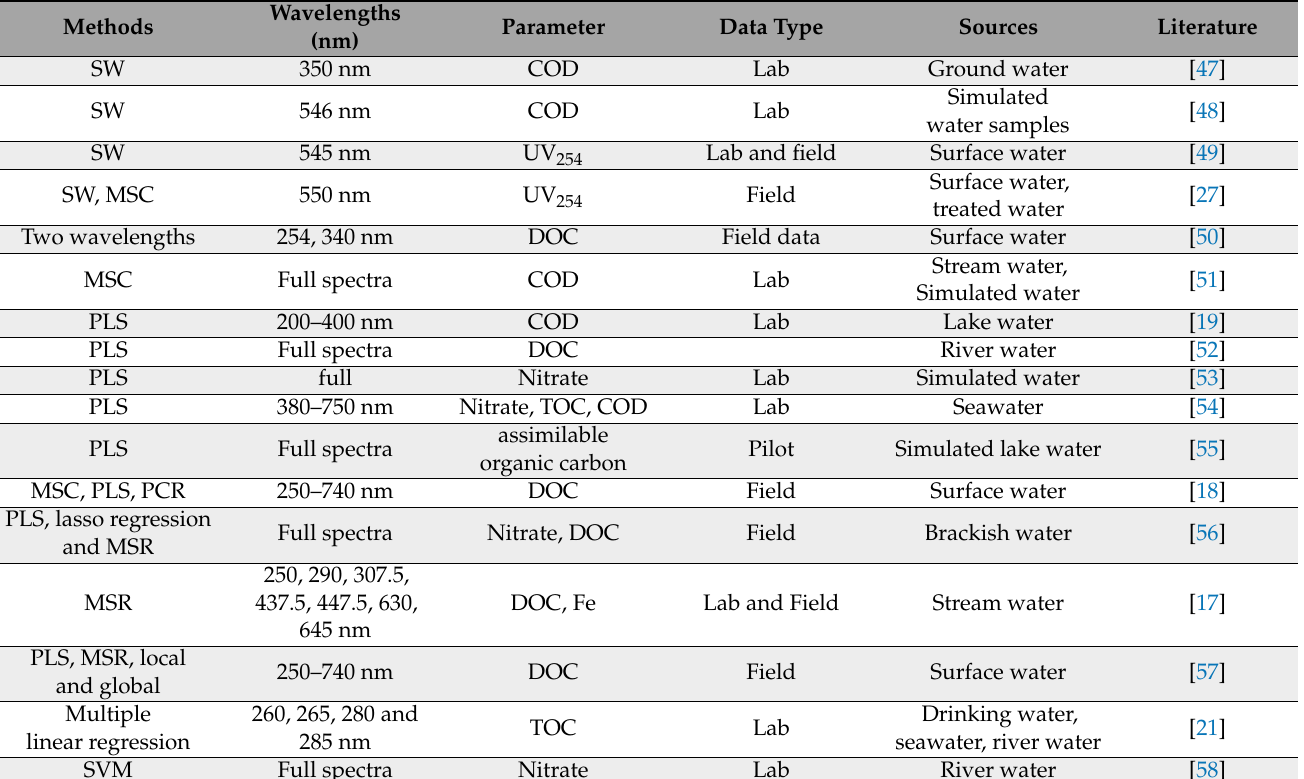
Table 2. Summary of indirect particle compensation methods for online water quality